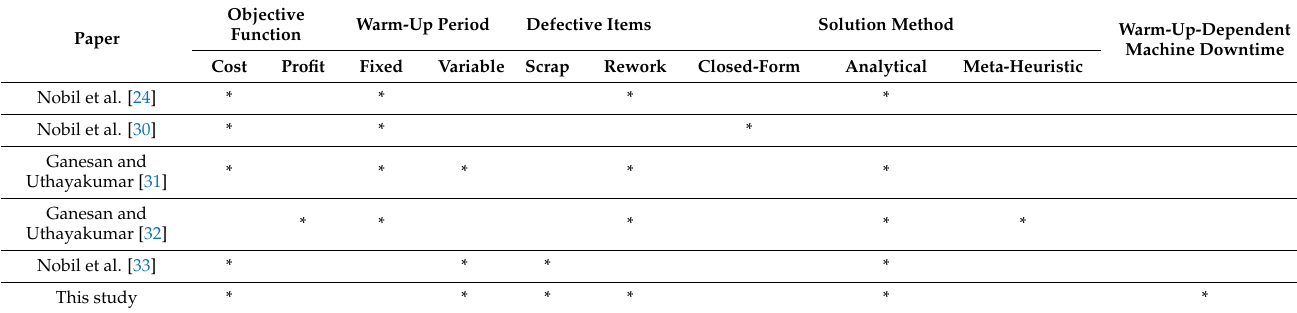
Table 1. A comparison of recent studies related to the warm-up